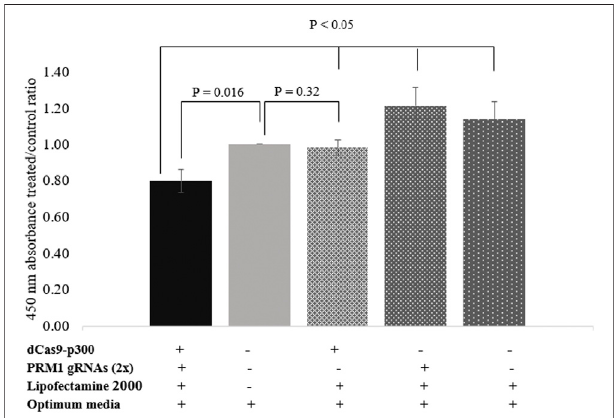
FIGURE 3 | Proliferation assay using BrdU assay. Values on the Y -axis representtheratioof450 nmabsorbanceoftreatedcellstocontrolcells.Error bars represent the standard error of the mean. Results were obtained from three biological replicates. (-) indicates absence of component in transfection complex. (+) indicates presence of component in transfection